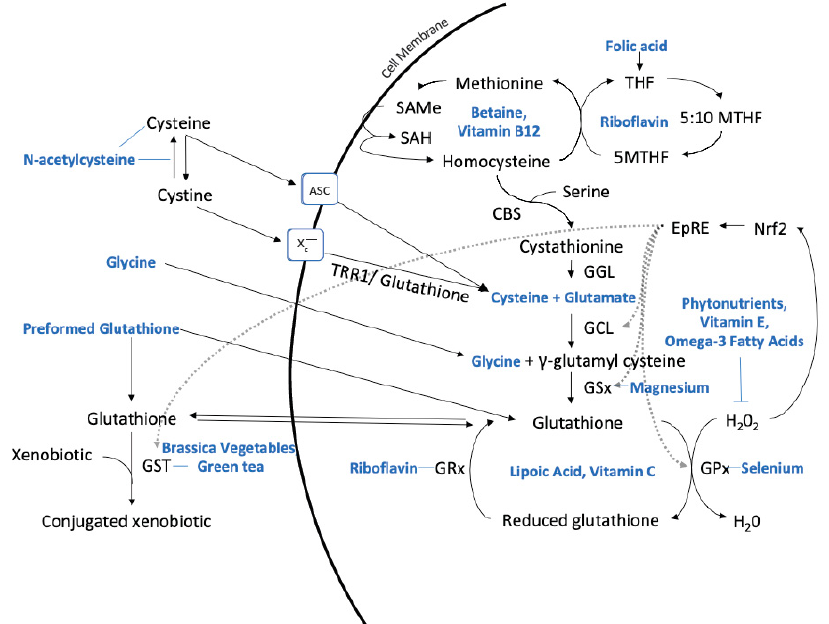
Figure 1. Hepatic synthesis of glutathione and nutritional substrates, co-factors, and other nutrients that influence metabolism. Key: 5-Methyl-tetrahydrofolate (5MTHF), system alanine–serine–cysteine